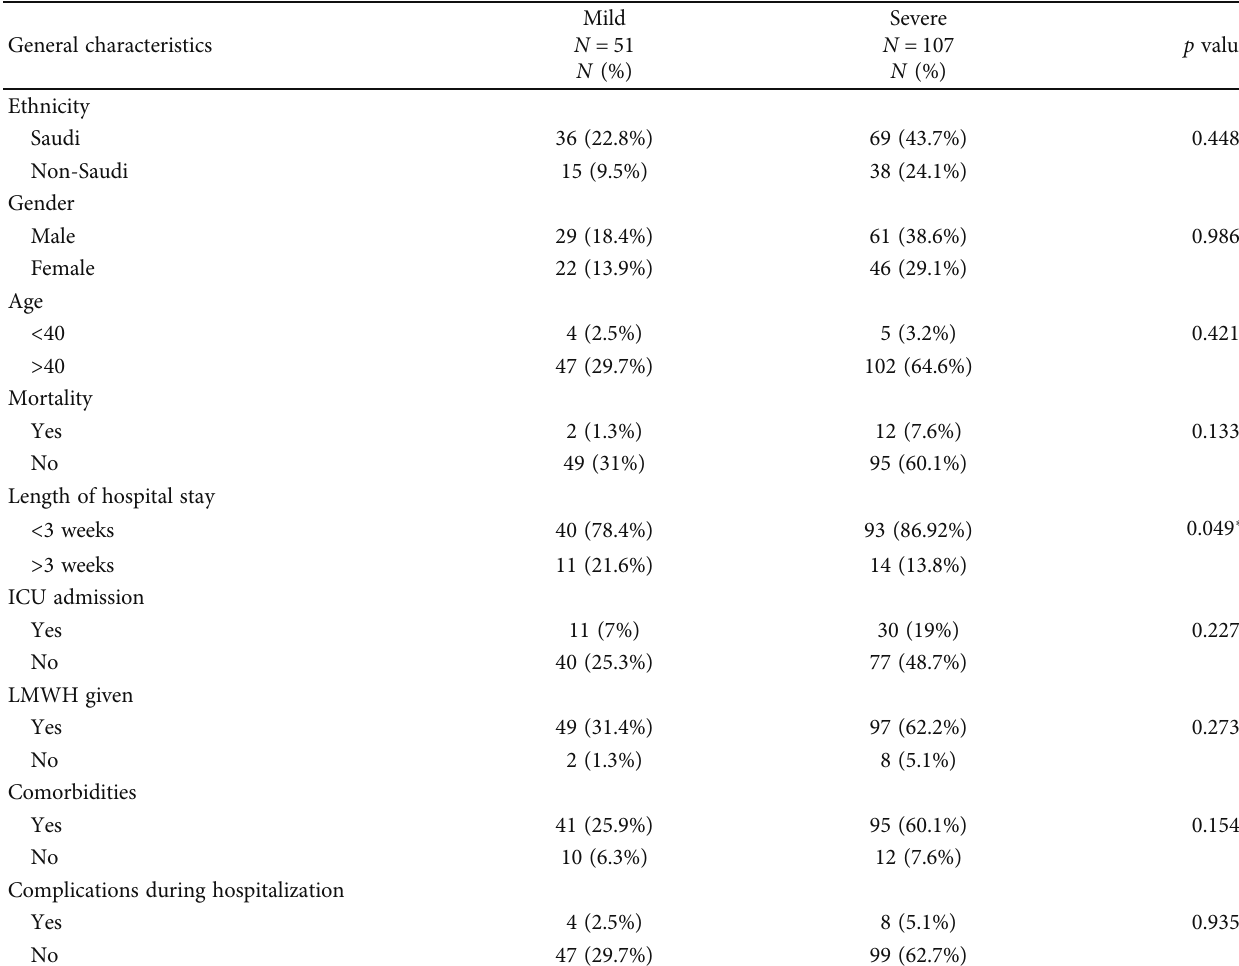
Table 1: Demographic features of patients with COVID-19 infection and diabetes mellitus at the time of admission with mild or severe illness ( n = 158